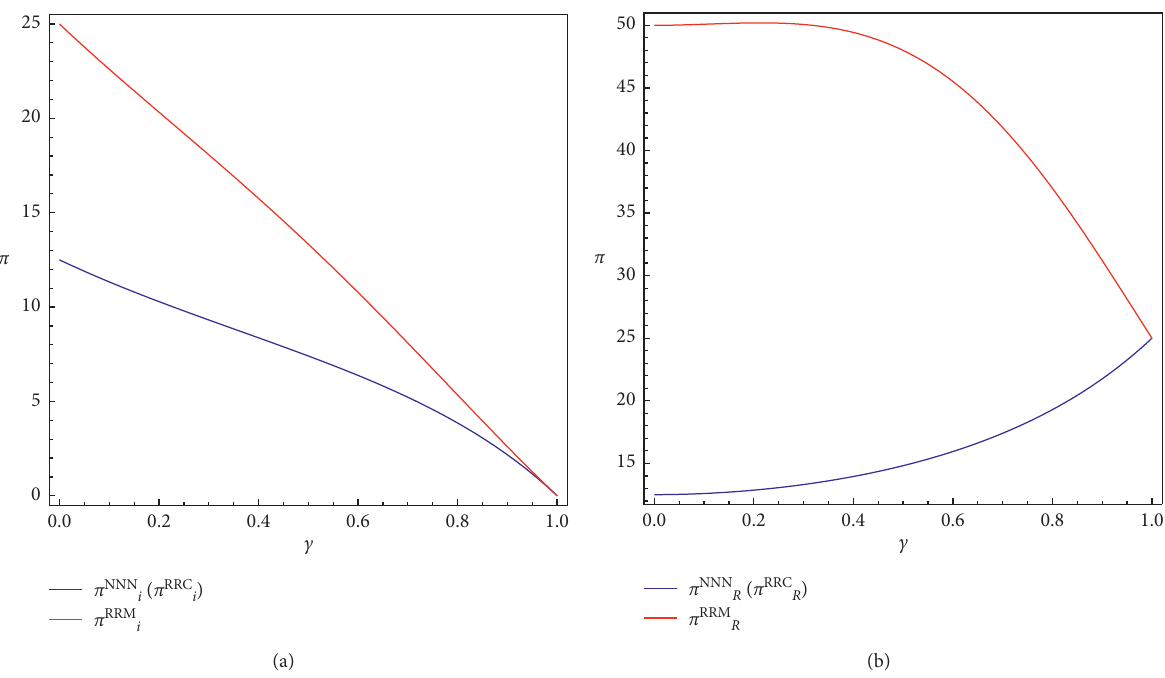
Figure 2: Manufacturers’ and retailer’s profits in the duopoly supply chain system versus c ( a � 10 ,m � ( 1/2 )) . (a) Manufacturers’ profits. (b) Retailer’s profits.